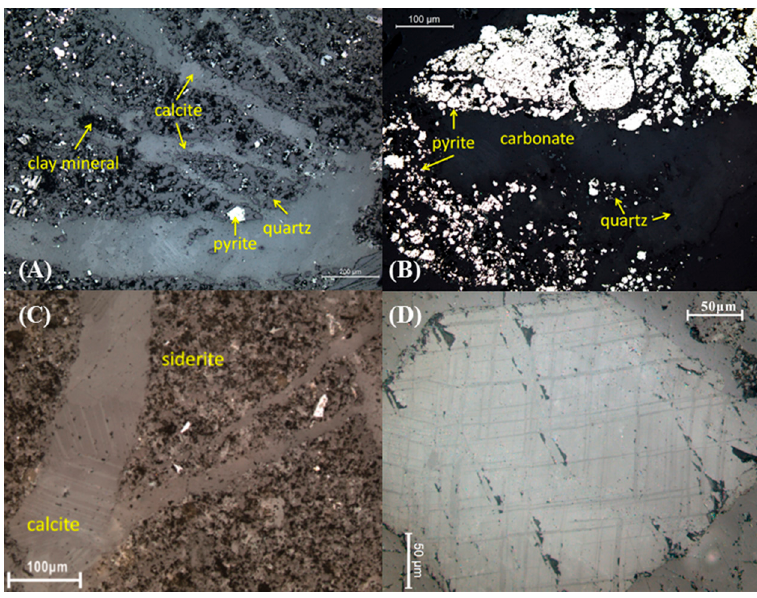
Figure 10. ( A ) Vein-like calcite; ( B ) massive carbonate mineral and pyrite; ( C ) vein like calcite and massive siderite; ( D ) euhedral calcite.